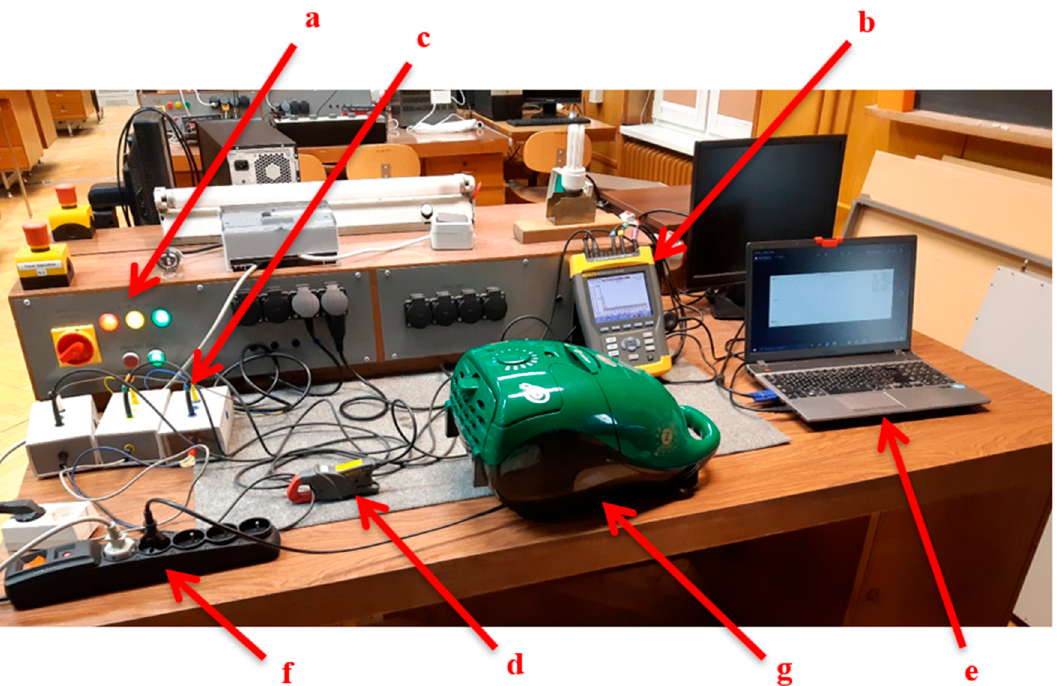
Figure 5. Laboratory measurement stand for testing the impact of nonlinear devices on power quality: ( a ) power supply AC 230 V 50 Hz; ( b ) power quality analyzer Fluke 435; ( c ) adapter for measuring voltage in a single-phase circuit; ( d ) measuring clamp; ( e ) PC with FlukeView software; ( f ) adapter for testing a set of electrical equipment; ( g ) electrical equipment under test.